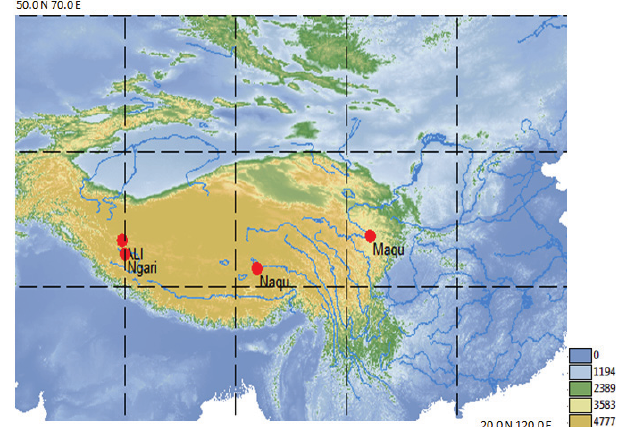
Fig. 1. Location of the three regional networks of the Tibetan Plateau soil moisture and soil temperature Observatory (Tibet-Obs). The legend indicates the altitude above mean sea level in meters.